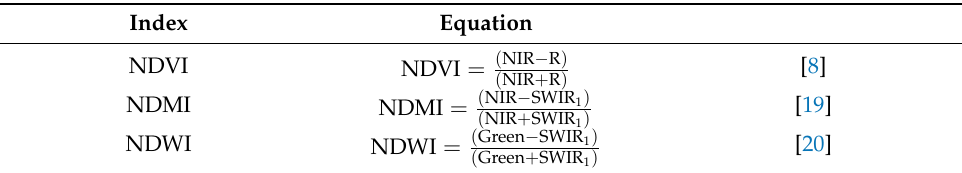
Table 1. Spectral indices used to assess the Iraqi